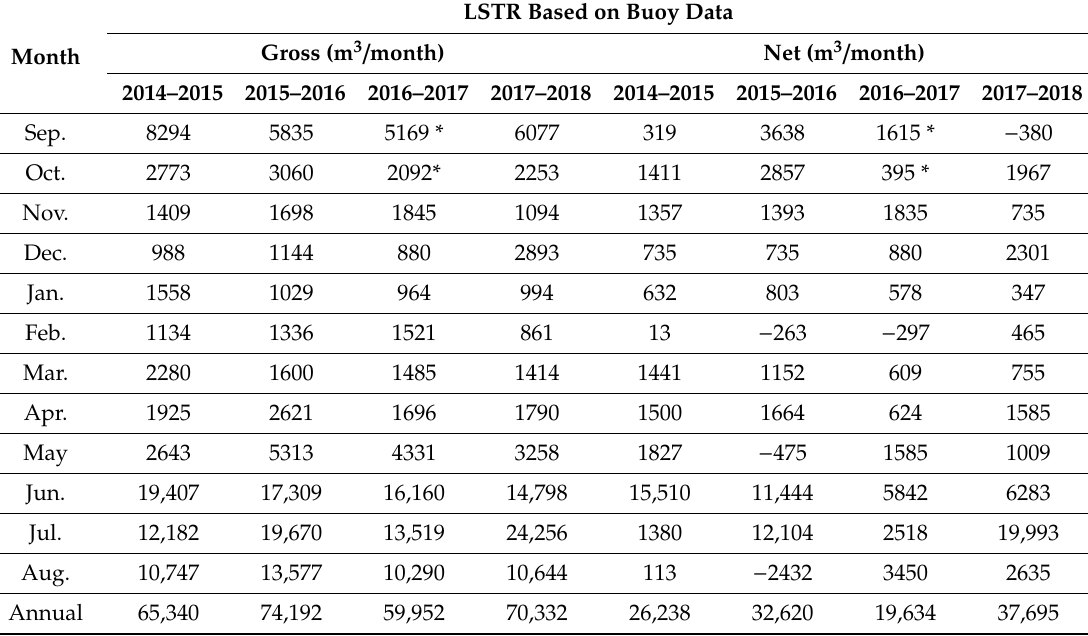
Table 5. Monthly net and gross longshore sediment transport rate using the measured buoy data for four years. LSTR Based on Buoy